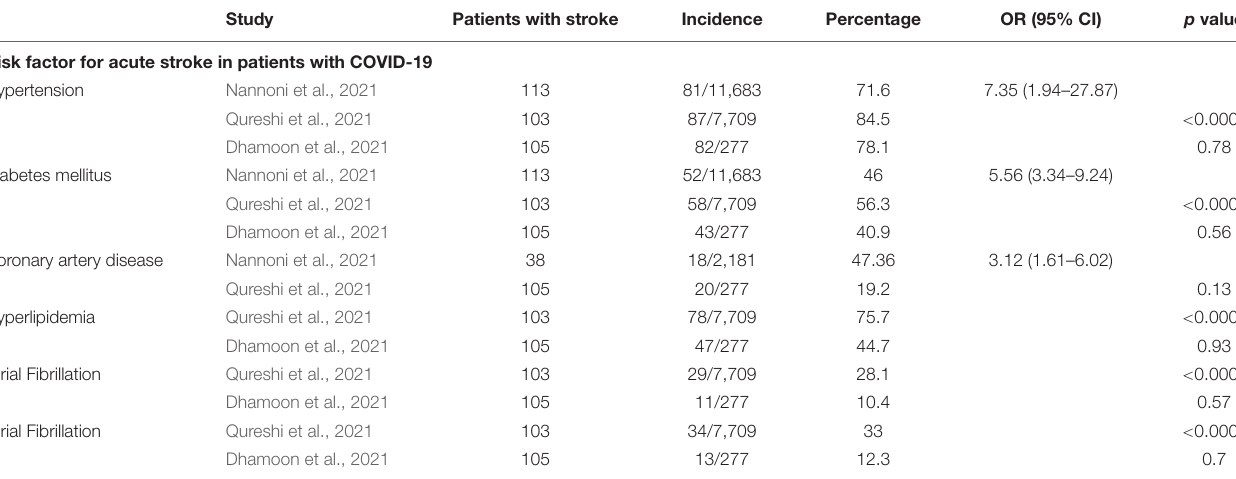
TABLE 1 | Cardiovascular risk factors for acute stroke in COVID-19 patients from recent studies. Study Patients with stroke Incidence Percentage OR (95% CI) p